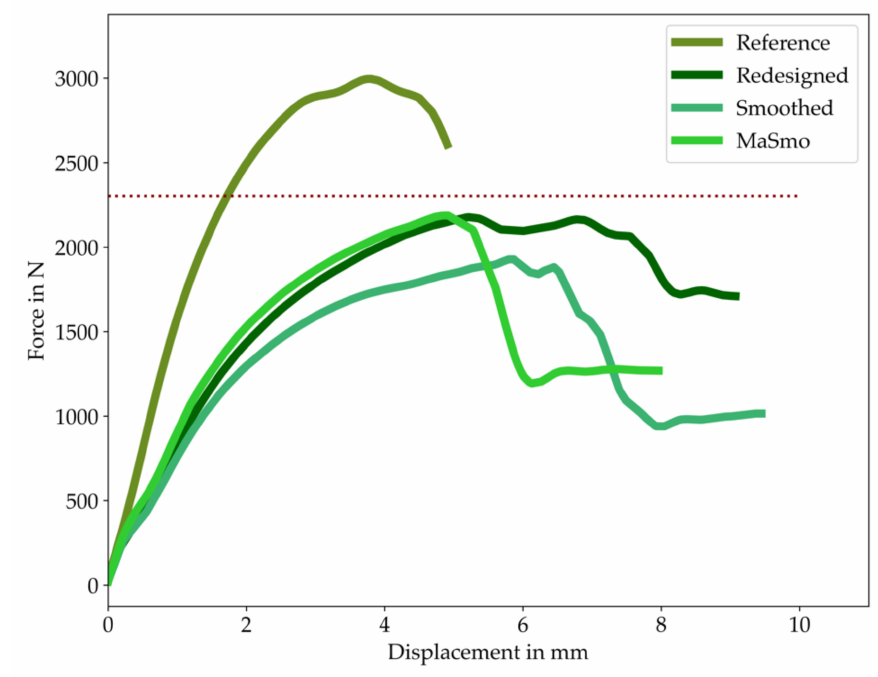
Figure 17. Comparison of the approximated force–displacement behavior of all configurations. The red dotted line indicates the level 75% of the reference’s maximum